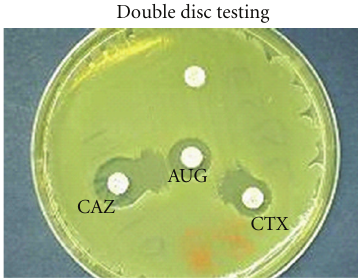
Figure 2: Synergy is seen as an expansion of the cephalosporin zone adjacent to the clavulanate containing disc CAZ—good substrate for TEM and SHV’s, CTX—Good for CTX-M ESBLs. The organism may appear resistant to 3rd-generation cephs, but susceptibility is restored by the presence of clavulanate.